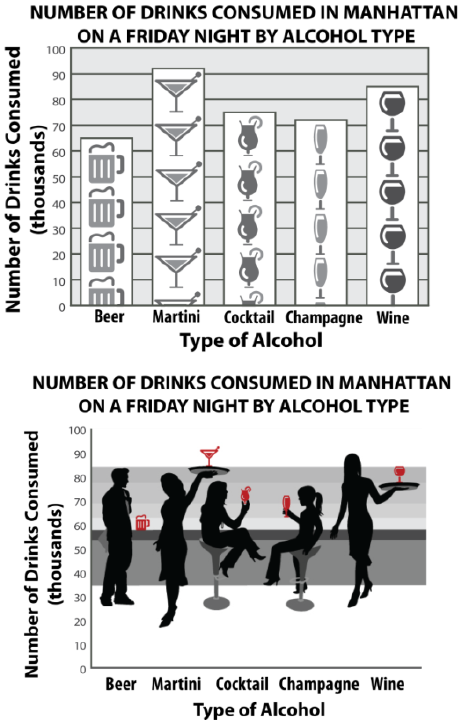
Figure 30. Bateman et al. compare two different levels of graphical embellishment of the same data. The top graph is an embellished image but still retains the recognisable features of a bar chart. The bottom image replaces the bars with a silhouette of a person next to a drink where the height of the drink corresponds to the height of the original bar. This method also uses the addition of color to emphasize the data [15]. Image courtesy of Bateman et al. [15].